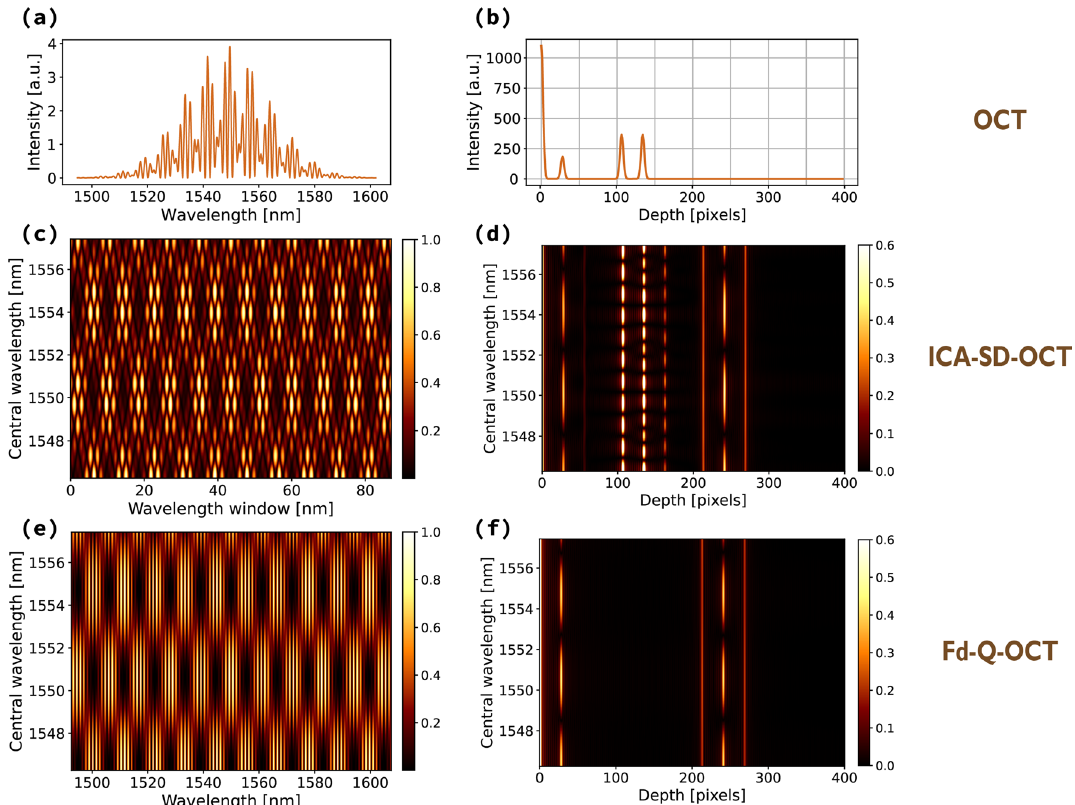
Figure 2. ( a ) A simulated spectrum in Fd-OCT corresponding to an object consisting of two scattering centres. ( b ) Its Fourier transform depicting two structural peaks representing the object (cross-correlation terms)